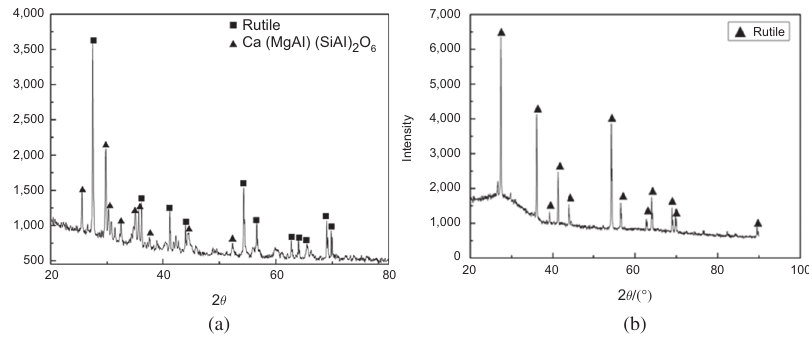
Figure 13: XRD pattern of the modified slag: (a) 0.5 K/min and (b) 4